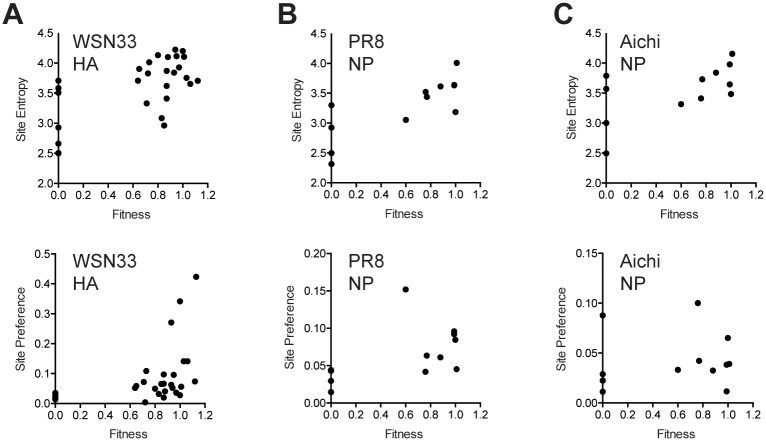
Correlation of fitness values with site entropy and preference.(A) Fitness of nonsynonymous HA mutants vs. site entropy (top) and fitness of all HA mutants vs. site preference (bottom) as reported in [46]. Unscaled values are shown. Correlations were similar for scaled values, see S3 Table. (B) Fitness of nonsynonymous NP mutants vs. site entropy (top) and fitness of all NP mutants vs. site preference (bottom) as reported for PR8 in [55]. (C) Fitness of nonsynonymous NP mutants vs. site entropy (top) and fitness of all NP mutants vs. site preference (bottom) as reported for A/Aichi/1968 (H3N2) in [55]. Note that scale in (A) for site preference is different as there were synonymous mutants in this dataset, but not in the NP datasets.